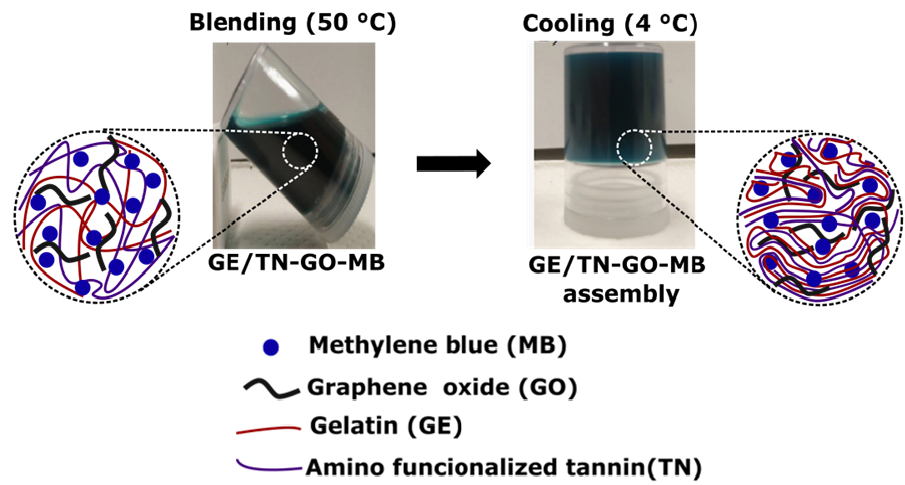
Figure 2. G’ and G” as a function of the temperature for GE/TN-GO-MB systems with different GO content. ( A ) 1-GE/TN-GO-MB; ( B ) 2-GE/TN-GO-MB; ( C ) 3-GE/TN-GO-MB; and ( D ) 4-GE/TN-GO-MB.